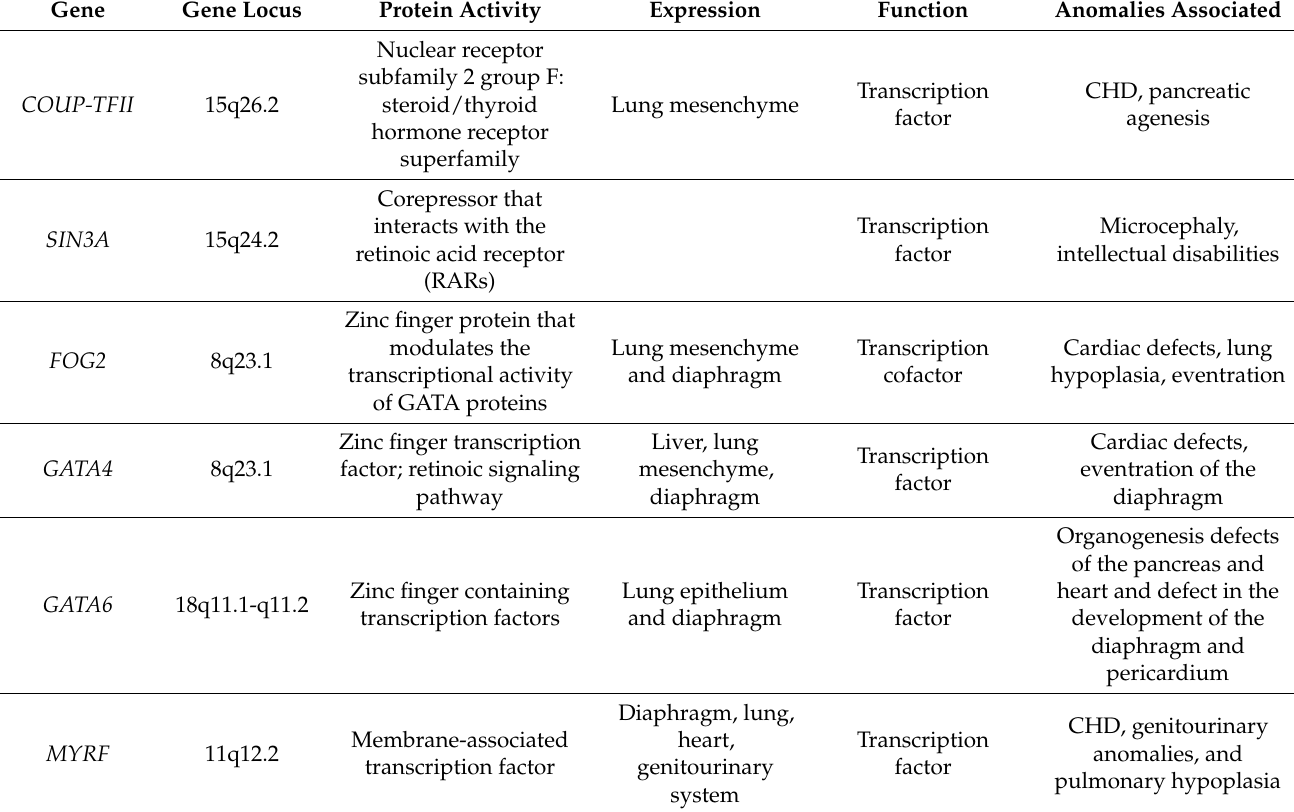
Table 1. Overview of candidate genes and signaling pathways for congenital diaphragmatic hernia (CDH). Gene Gene